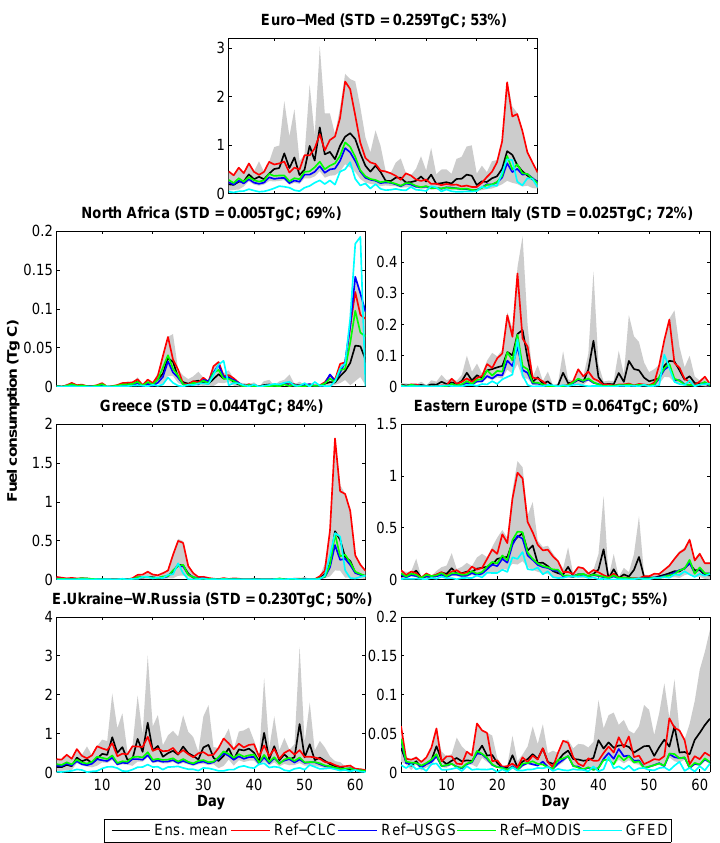
Fig. 11. Daily fuel consumption for the ensemble mean, and the reference configuration and either CLC, MODIS or USGS landcover types for July–August 2007. The spread of the ensemble is indicated by the shaded gray area. The values from the GFED inventory are also plotted for comparison. The average standard deviation (absolute value and relative to the ensemble mean) is indicated on top of each plot.